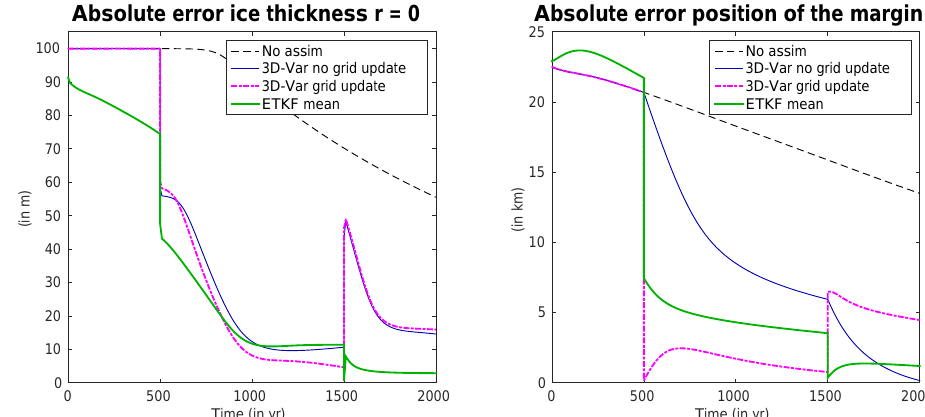
Figure 9. Evolution of the absolute error of the estimated ice thickness at r = 0 and the estimated position of the margin when we observe only the ice thickness. We compare the absolute errors obtained when we use 3D-Var without and with correction of the position of grid nodes and when we use an ETKF.